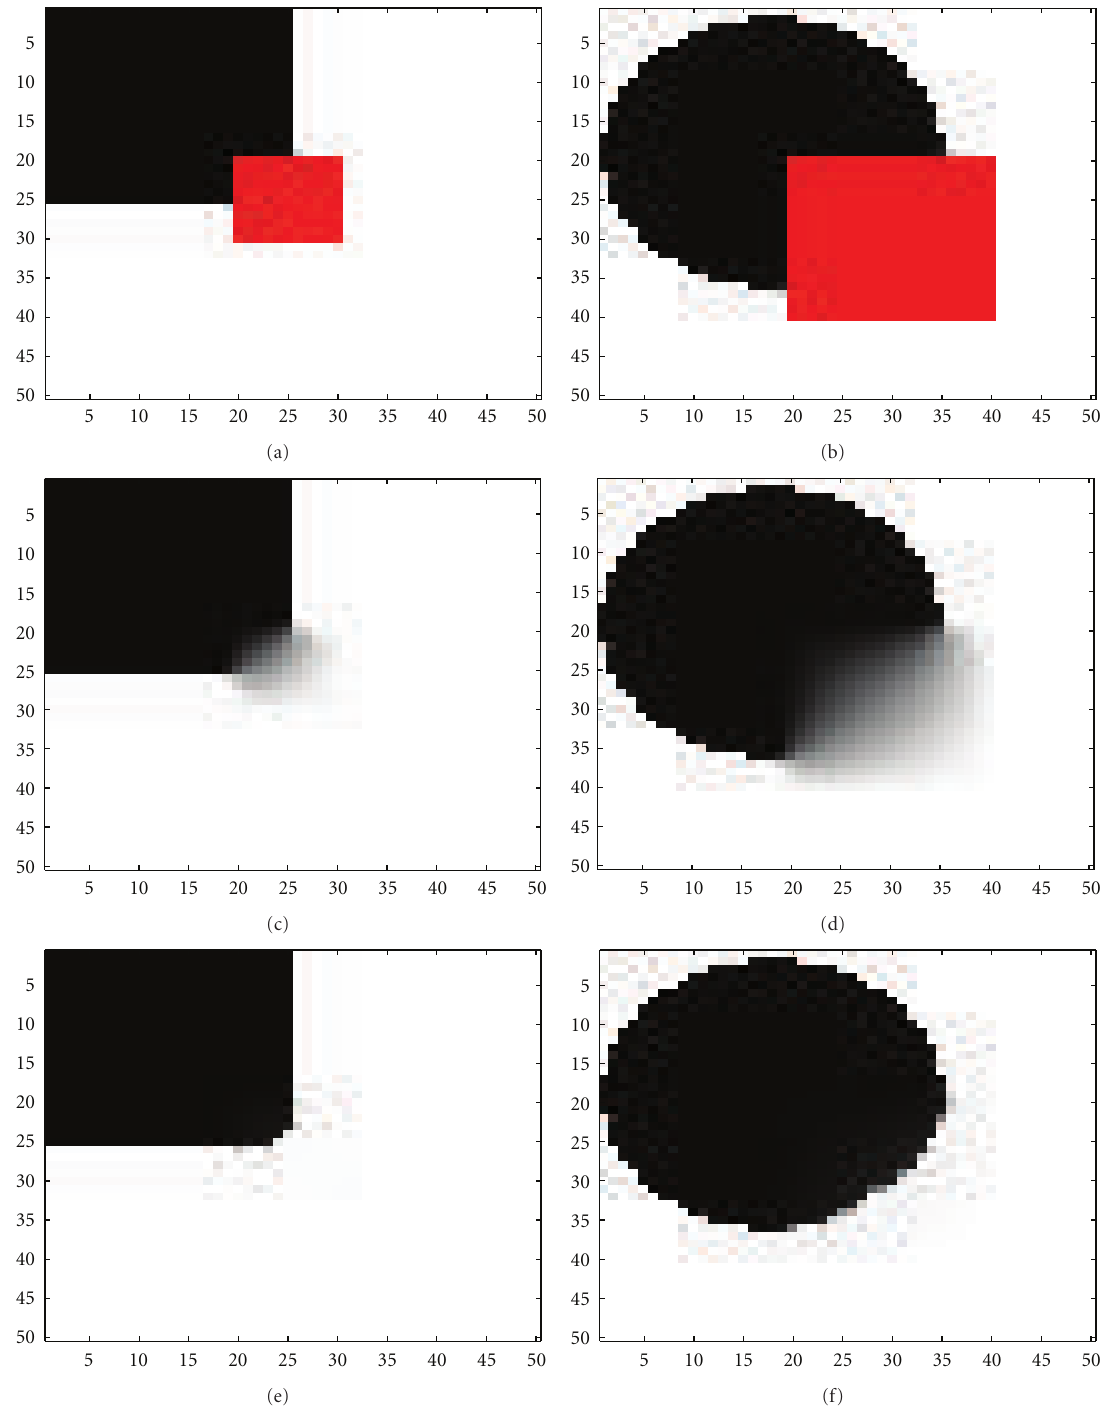
Figure 4: (a) Occluded image, defined by a black square on a white background, the occlusion being represented by a red square; (b) Occluded image, defined by a black circle on a white background, the occlusion being represented by a red square; (c) Inpainted image by di ff usion (see (a) for the original degraded image), without any inserted edge in the occlusion; (d) Same as (c) in the circle case; (e) Inpainted image using the missing edges identified by the topological gradient, and then di ff usion to fill in the image (see (a) for the original degraded image); (f) Same as (e) in the circle